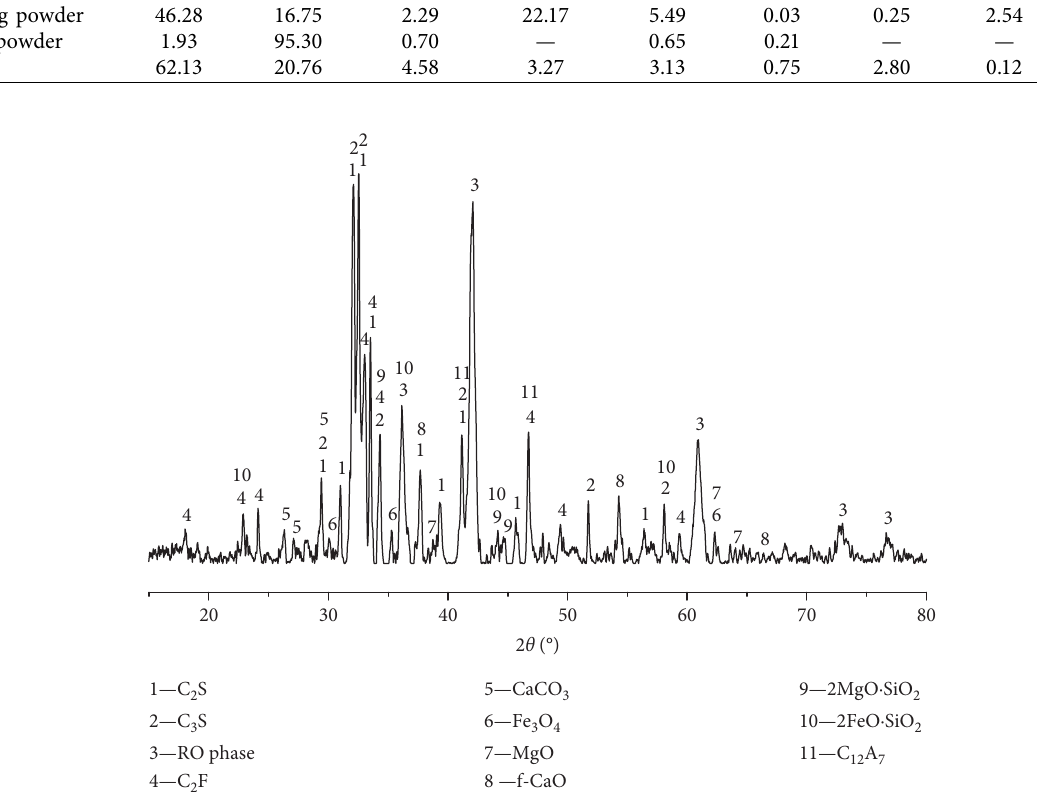
Figure 1: XRD pattern of steel slag used in this study. Table 2: Median diameters of steel slag and quartz powder ( μ m). Materials